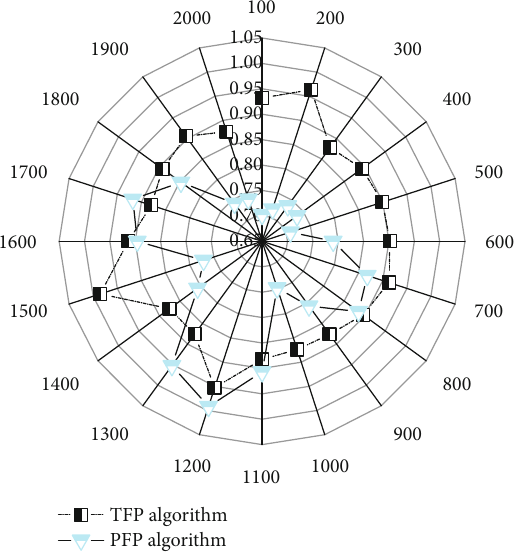
Figure 5: Correlation between the size of multisource data sets and the development of children ’ s innovative ability. Table 6: The overall model fi t index of the structural model analysis of the in fl uencing factors of children ’ s innovation